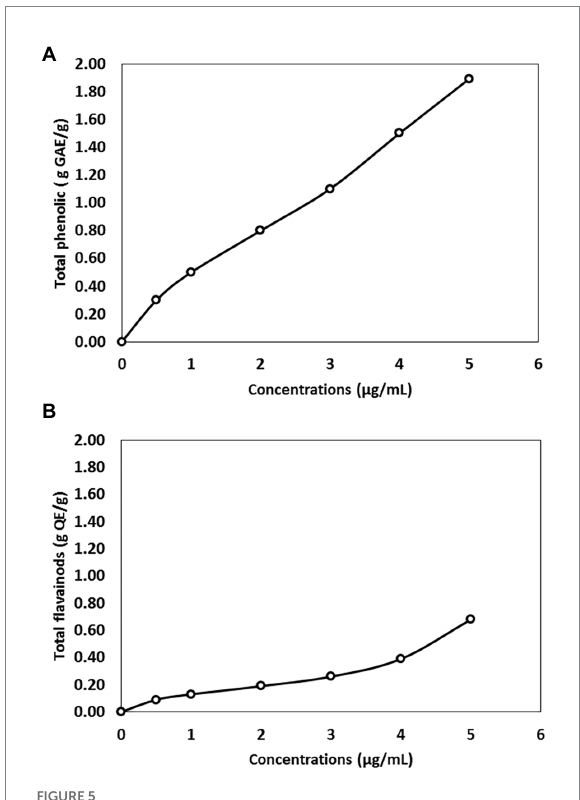
FIGURE 5 (A) Total phenolic content expressed as gallic acid equivalent (GAE) in biosynthesized selenium nanoparticles (BioSeNPs) suspension, fabricated by Bacillus subtilis AS12. (B) Flavonoids content expressed as Quercetin quercetin equivalent in BioSeNPs suspension fabricated by Bacillus subtilis AS12.